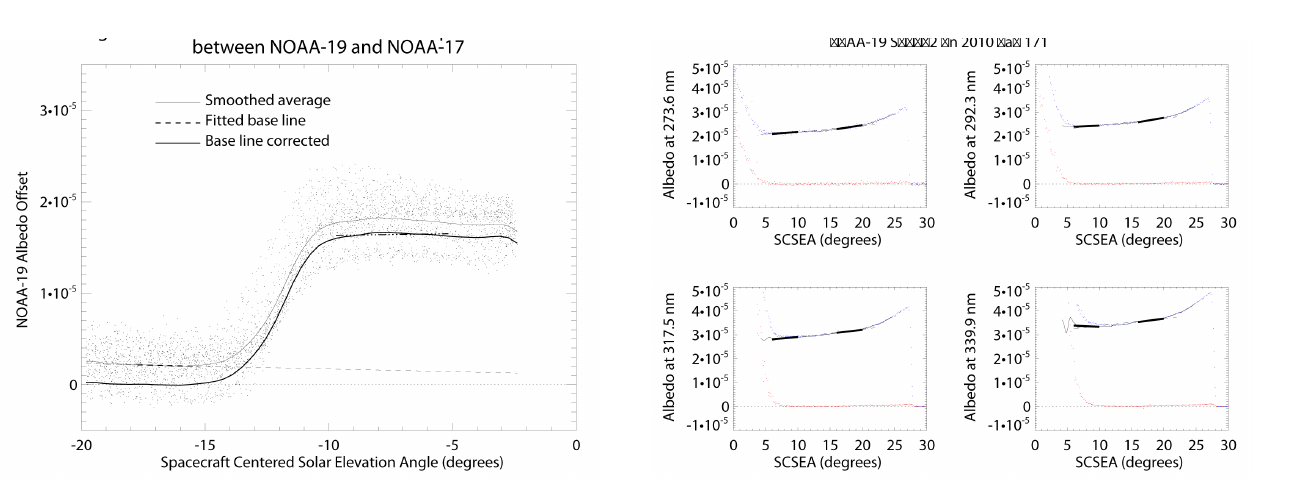
Fig. 7. Two years of data points from IPAR comparisons between N19 and N17 in the Northern Hemisphere illustrate the IBSL er- ror at 273nm as a function of SCSEA, a rapid rising edge and flat top before and after SCSEA =− 10 ◦ . Piece-wised linear fitting, weighted with statistical error of each point, is used to get a smooth average (thin solid curve). Then, it is corrected for background off- set which is an extrapolation of a straight line fitted between SC- SEA =− 20 ◦ and SCSEA =− 15 ◦ (dashed line). The final result for IBSL is plotted as a thick, solid curve.